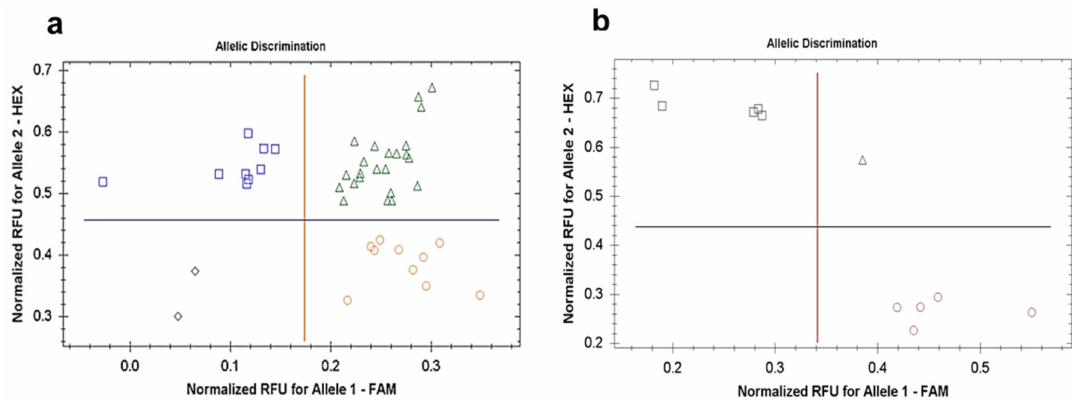
Figure 6. Allele discrimination plots for Amplifluor-like SNP genotyping of TaDrAp2-B1 in parents and 42 F 3 progenies of hybrid population No. 18-6 ( a ) and in nine F 5 -selected breeding lines from the same population ( b ). Normalized relative fluorescence units (RFU) for FAM and HEX fluorophores are indicated on the x - and y -axes. Red circles represent homozygote genotypes with allelle 1 (‘ aa ’), blue squares show homozygote genotypes with allelle 2 (‘ bb ’), heterozygotes for both alleles ‘ ab ’ are indicated by green triangles, and black rhomboids indicate unidentified genotypes. Sterile water, instead of DNA, was used as the no template control (NTC). Fluorescence was determined, scored, and shown automatically on the final time-point of amplification by BioRad software provided with the qPCR instrument. However, data were also checked manually. Genotyping was performed with a single biological replicate (each single plant from F 3 progeny) ( a ) and with three biological replicates (three plants from each F 5 breeding line) ( b ), repeated twice over di ff erent days (two technical